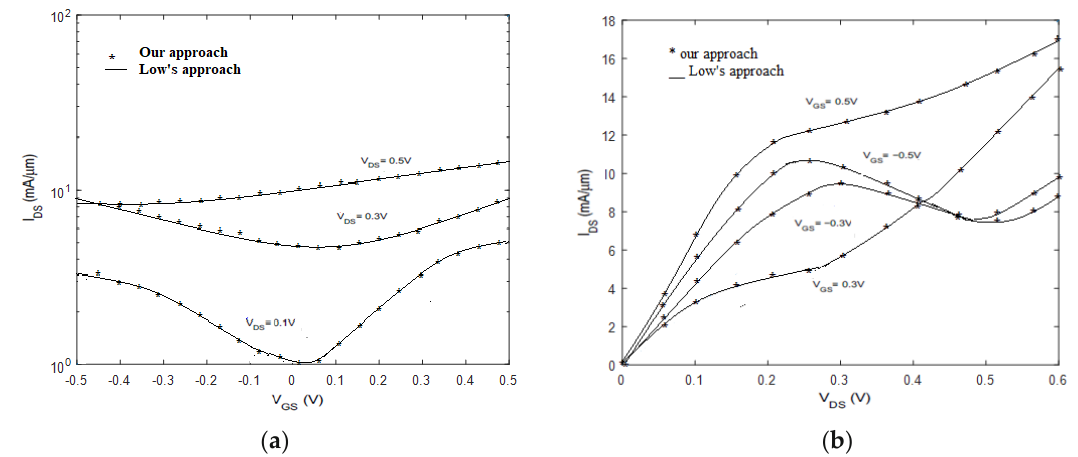
Figure 8. ( a ) Transfer characteristics. ( b ) Output characteristics of GFET, proposed method (solid line), and low’s approach (circles).